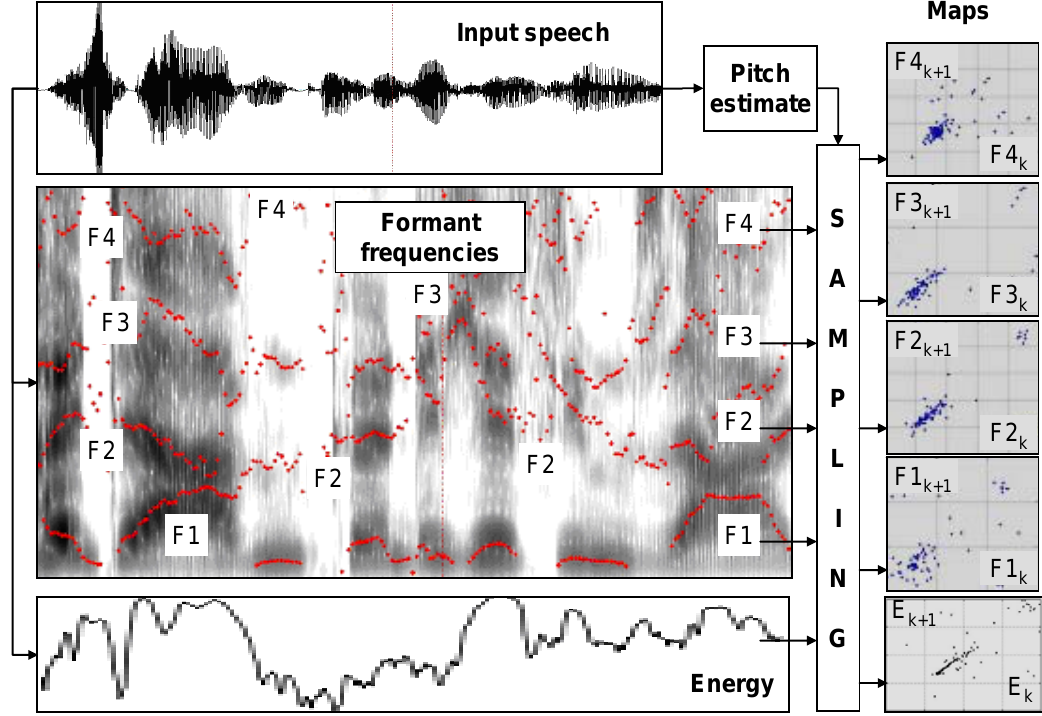
Figure 1. Block diagram of the adopted procedure for Poincare-mapping of the selected speech signal characteristics.